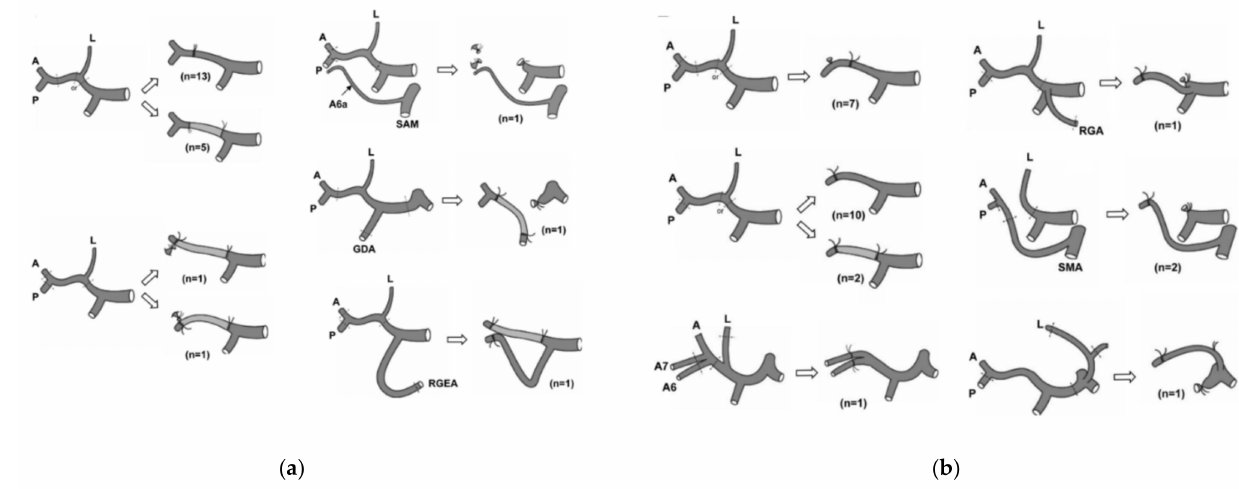
Figure 3. ( a ): Scheme of vascular resection for left hepatectomy. Type of hepatic artery resection and reconstruction during left hepatectomy. L: left hepatic artery; A: right anterior hepatic artery; P: right posterior hepatic artery; SMA: superior mesenteric artery; GDA: gastroduodenal artery; RGEA: right gastroepiploic artery; and A6a: artery supplying a small area of subsegment 6. ( b ) Hepatic artery resection and reconstruction in case of left trisectionectomy. L: left hepatic artery; A: right anterior hepatic artery; P: right posterior hepatic artery; RGA: right gastric artery; MA: superior mesenteric artery; A6: artery feeding segment 6; and A7: artery feeding segment 7. Note that